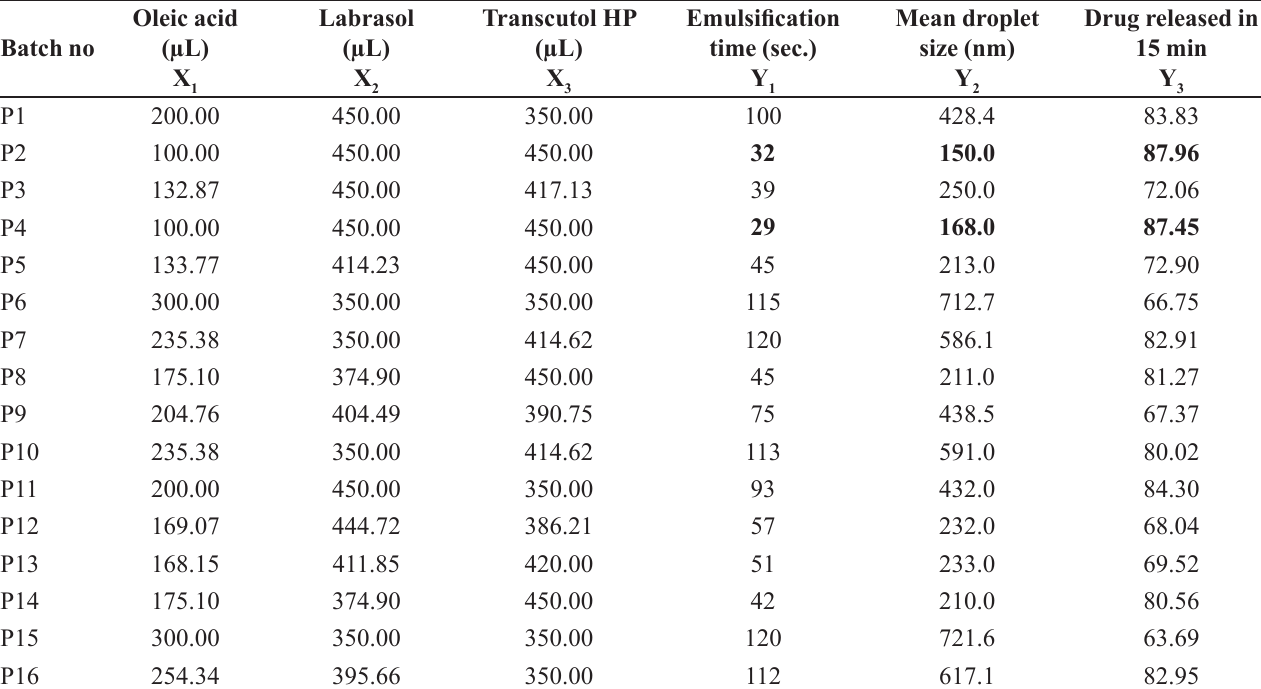
TABLE II - Formulation and Characterisation of D optimal mixture design batches Oleic Batch no